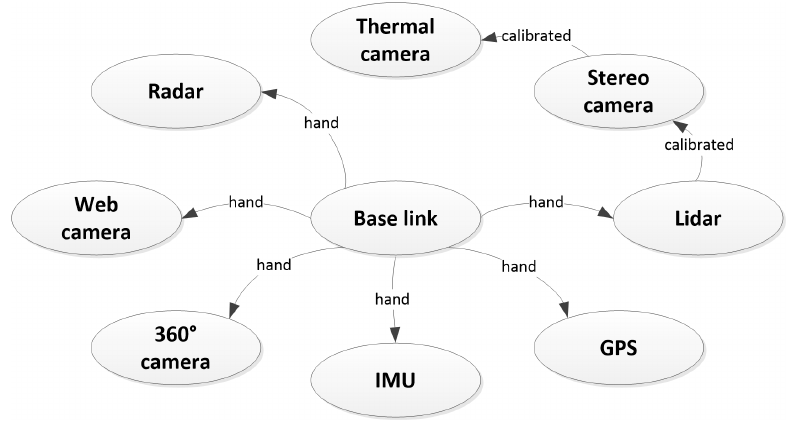
Figure 4. Sensor registration. “Hand” denotes a manual measurement by hand, whereas “calibrated” indicates that an automated calibration procedure was used to estimate the extrinsic